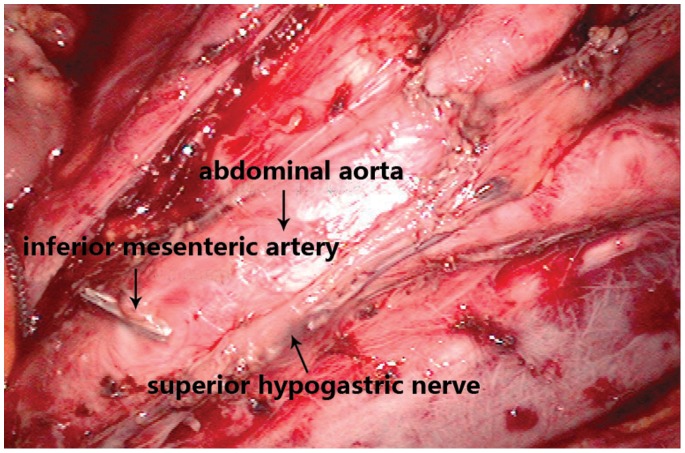
Preservation of the superior hypogastric nerve when removing lymph nodes.It is important to note that, superior hypogastric nerve is likely to be treated as connective tissue and be cut off in this procedure. Advantages of laparoscopy play an important role in this situation. Amplification of laparoscopy makes it easy to identify superior hypogastric nerve and thus damage could be avoided.